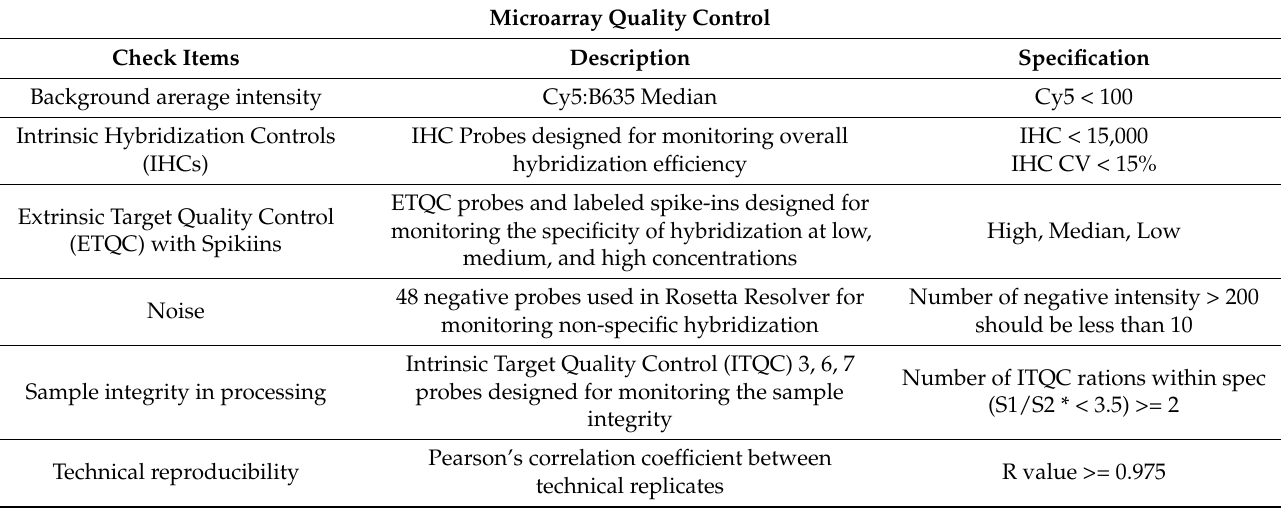
Table A1. Microarray quality control.